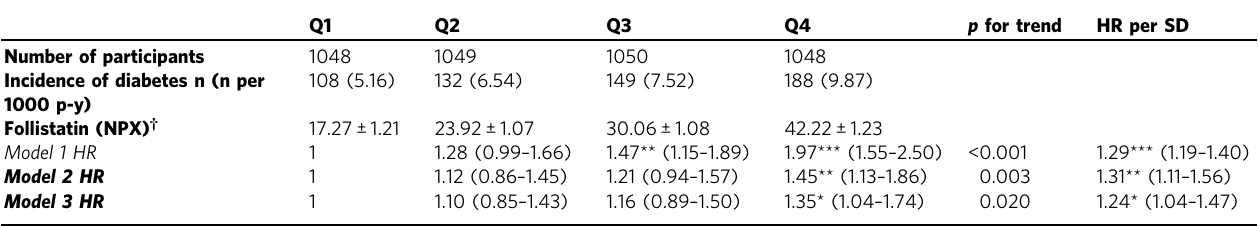
Table 2 Incidence of diabetes in relation to sex-speci fi c quartiles of plasma follistatin levels in MDC-CC.